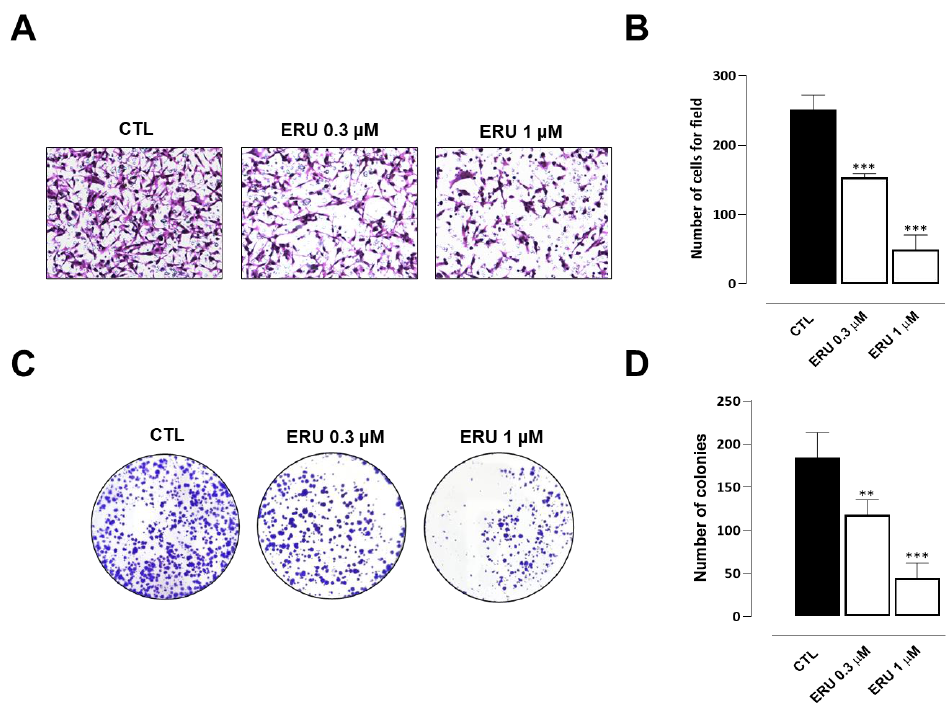
Figure 4. ERU inhibits the migration of MDA-MB-231 cells. ( A ) Representative photographs of migratory MDA-MB-231 cells treated with ERU (0.3 and 1 µM) at 0, 24 and 48 h. ( B ) The scratched areas were quantified in three random fields in each treatment. Data are shown as mean ± SEM of three independent experiments ( n = 3). ** p < 0.01; *** p < 0.001 vs. CTL.